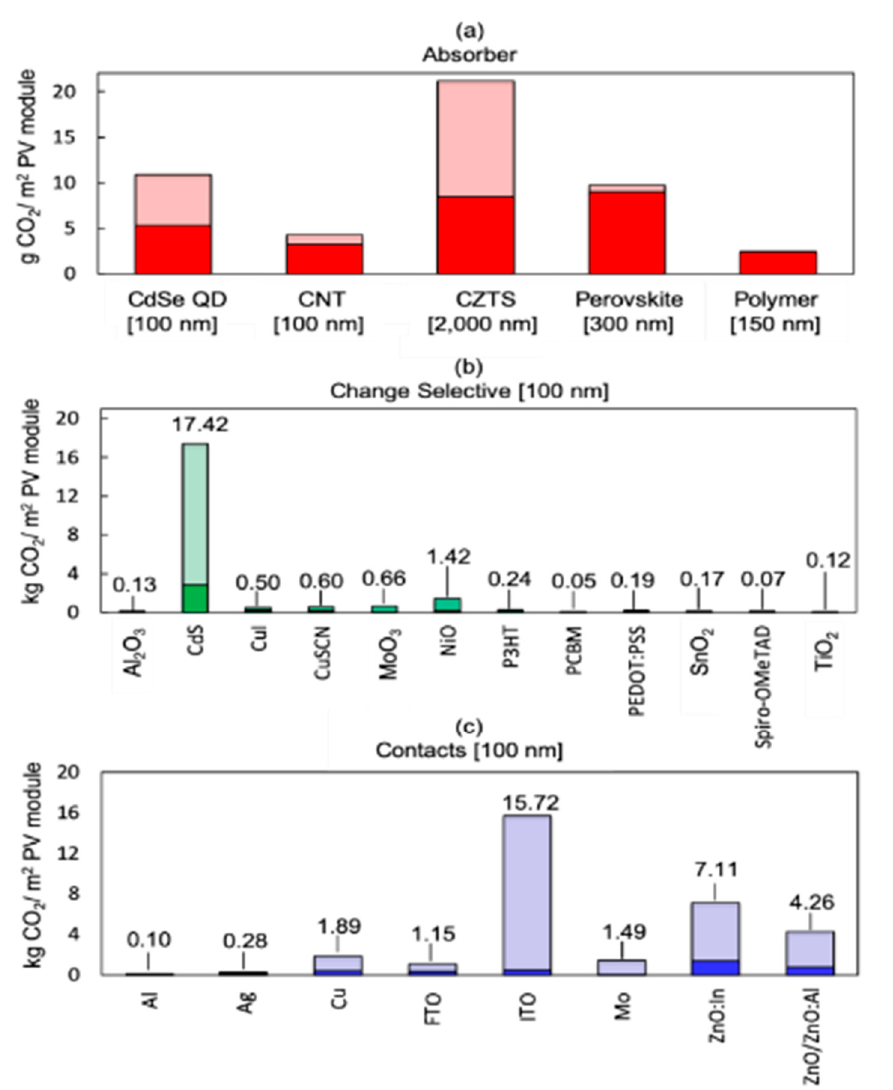
Figure 2. The global warming potential (GWP) breakdown of emerging materials. Note that the y axis for the absorber materials is in g whereas it is in kg for contacts and charge selective layers. Dark shades represent the material cost while the light shades correspond to the processing electricity cost. The life cycle carbon emissions (global warming potential, GWP) of the absorber ( a ), charge selective ( b ) and contact materials ( c